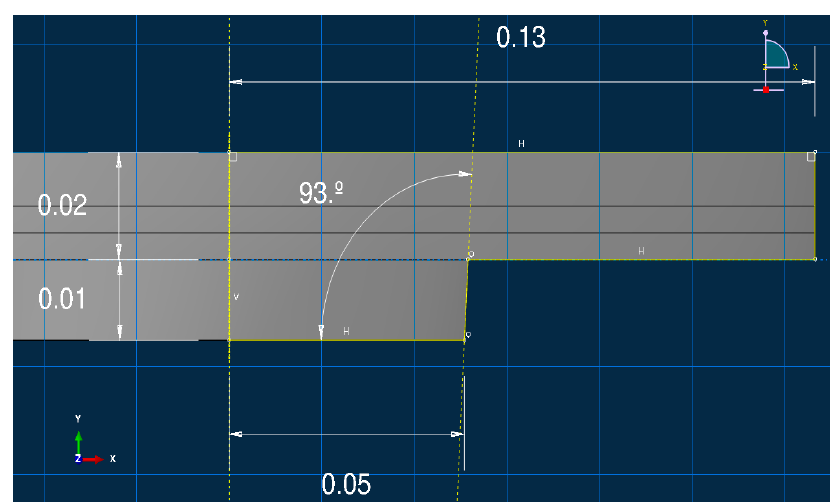
Figure 11. The stub-hole geometry dimensions (m).